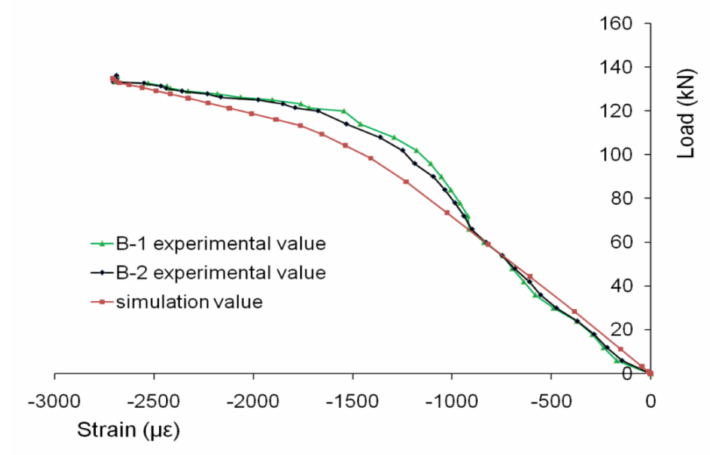
Figure 17. Comparison of load-strain curves of steel upper flange.